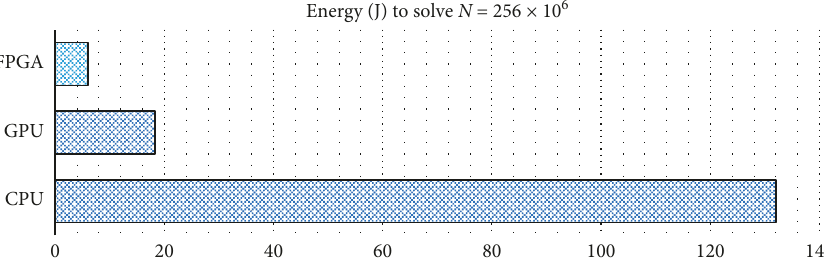
Figure 10: Joules required to solve a tridiagonal system of N � 256 × 10 6 per device using the oclspkt routine.